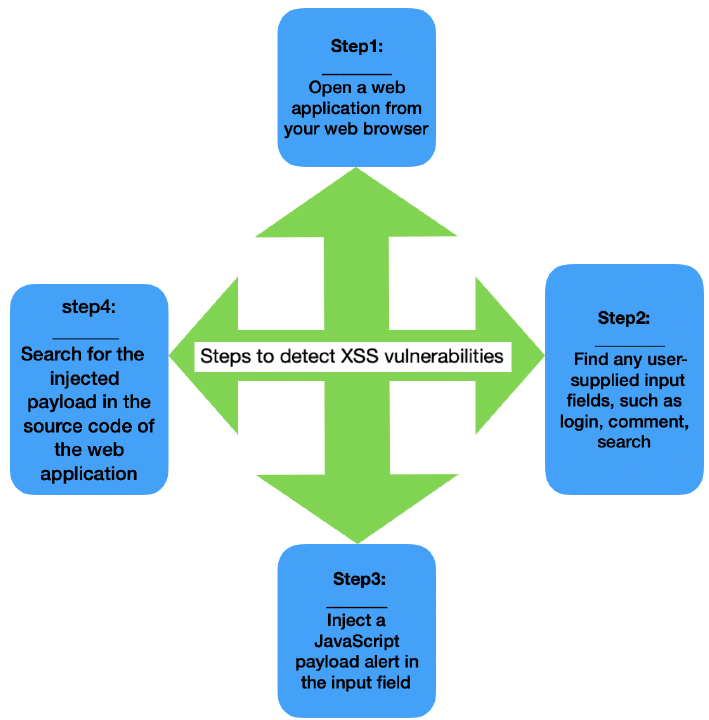
Figure 2. Steps to discover XSS